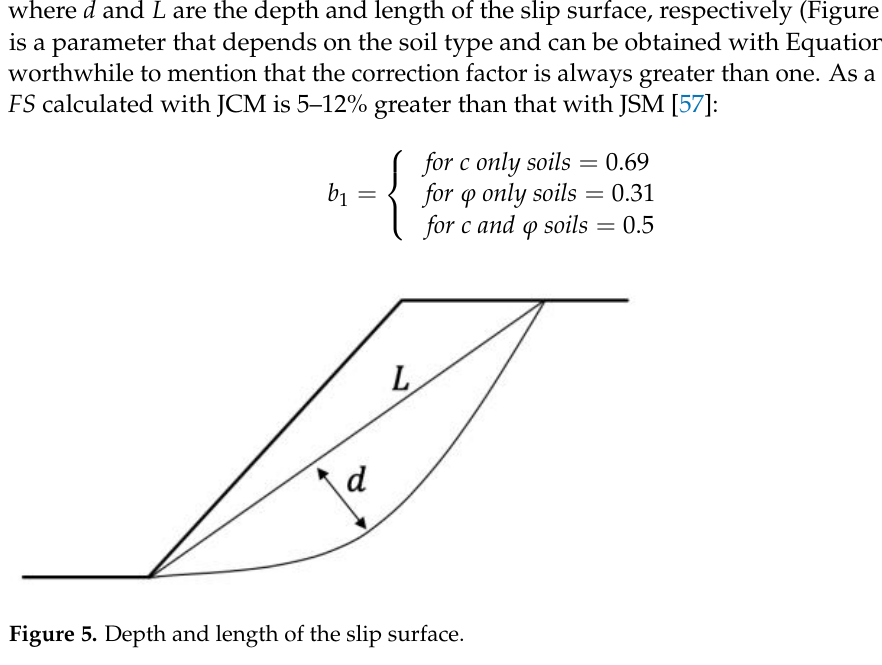
Figure 5. Depth and length of the slip